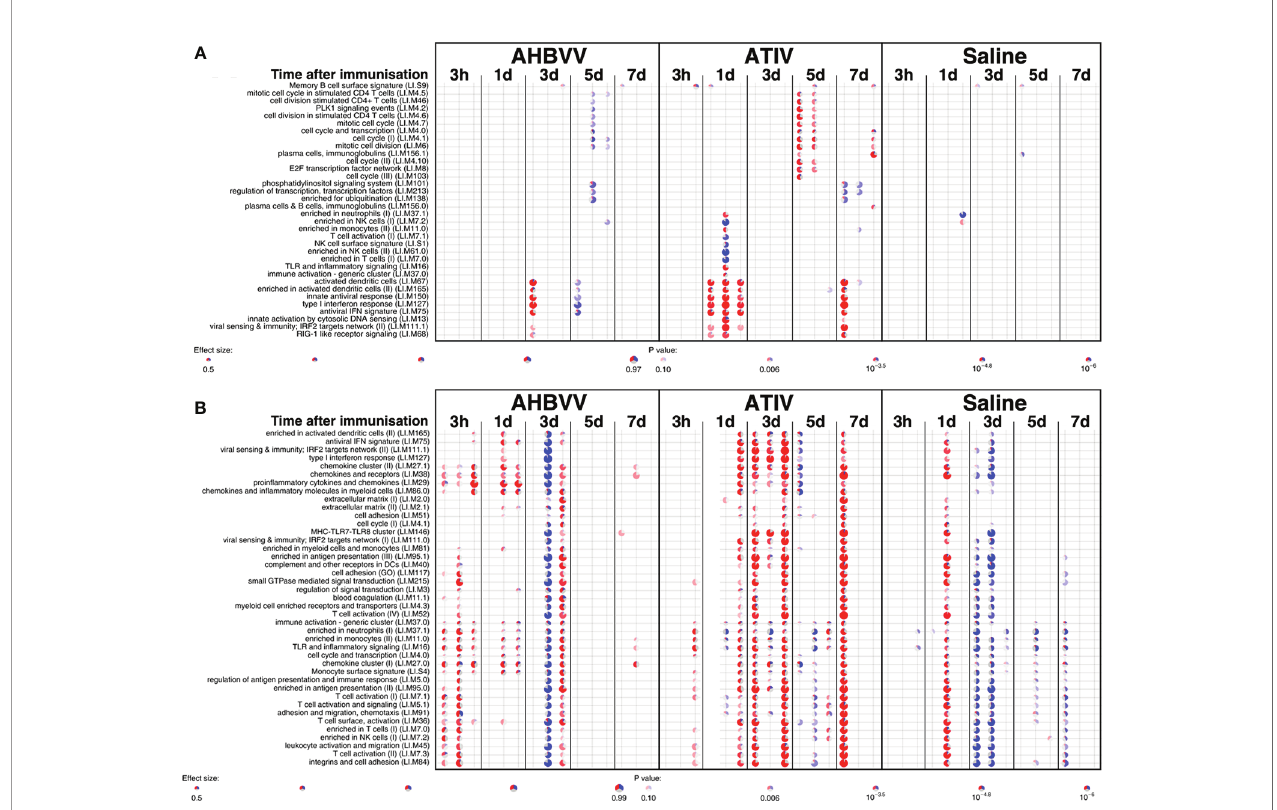
FIGURE 7 | Gene expression in whole blood and muscle from individual participants at different time points after immunization. Gene set enrichment analysis of signatures at different time points after immunization in the whole blood [pre-immunization time point control (A) ] and immunized leg muscle biopsy [paired unimmunized leg biopsy as control, (B) ]. Pie diameters correspond to effect size (AUC) in the enrichment and intensity of color to p value of enrichment (stronger color indicates lower p value). Red and blue sectors indicate fractions of genes that have, respectively, a higher or lower [abs(log2FC) > 0.5] expression in test group compared to